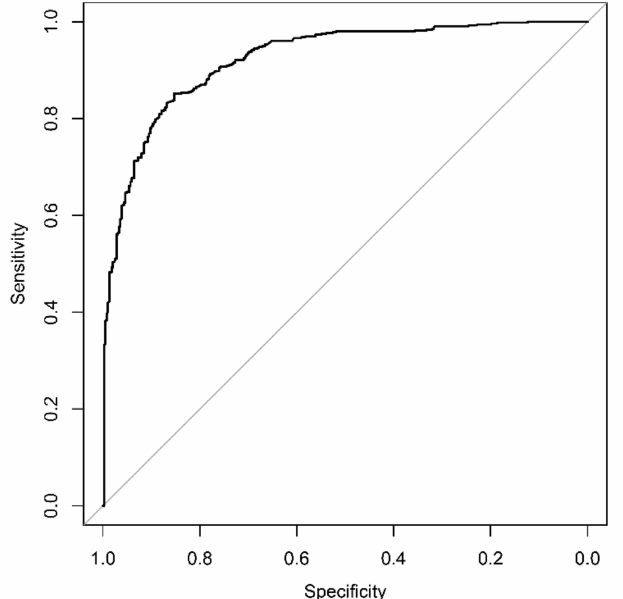
Figure 3. Diagnostic accuracy of the deep learning algorithm for detecting pneumonia. Opacifications and/or consolidations associated with pneumonia can be detected with a corresponding AUROC value of